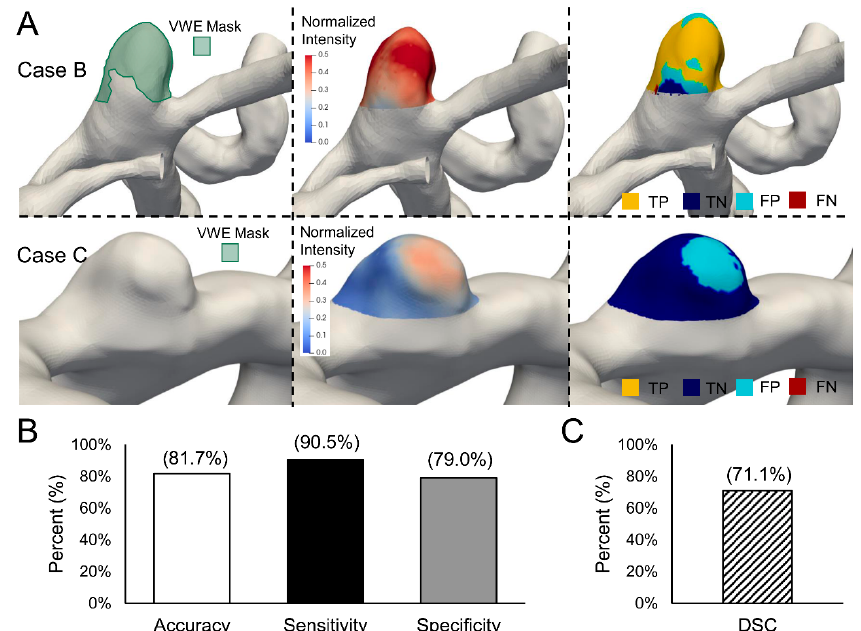
Figure 3. Results of VWE detection in the testing dataset. ( A ). Masks, mapped intensities and testing plots of 2 representative cases. Case B had a mask and Case C did not. The yellow, blue, cyan and red represent true positive (TP), true negative (TN), false positive (FP) and false negative (FN) classification of faces based on clinician marked voxels. Ideal case would have no FP and FN voxels. ( B ). Cumulative accuracy, sensitivity and specificity of all the faces in all the cases. ( C ). Average dice similarity coefficient (DSC) of only the cases with marked masks ( n = 4) in the testing cohort.